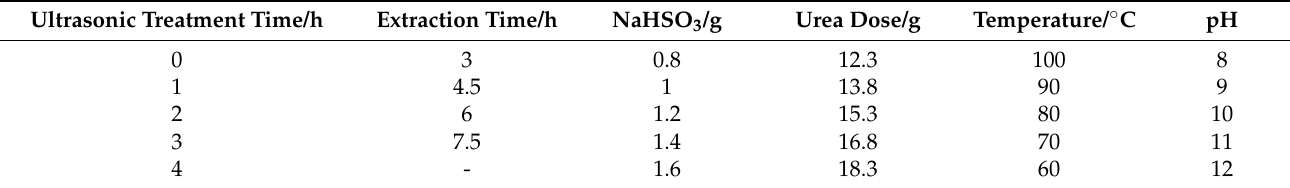
Table 1. Different extraction